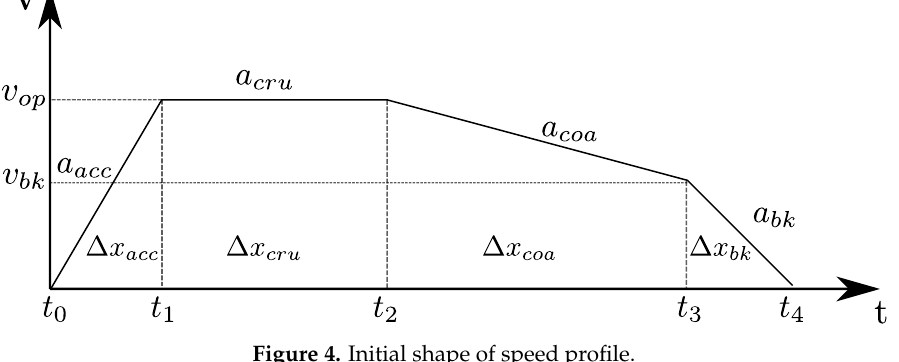
Figure 4. Initial shape of speed